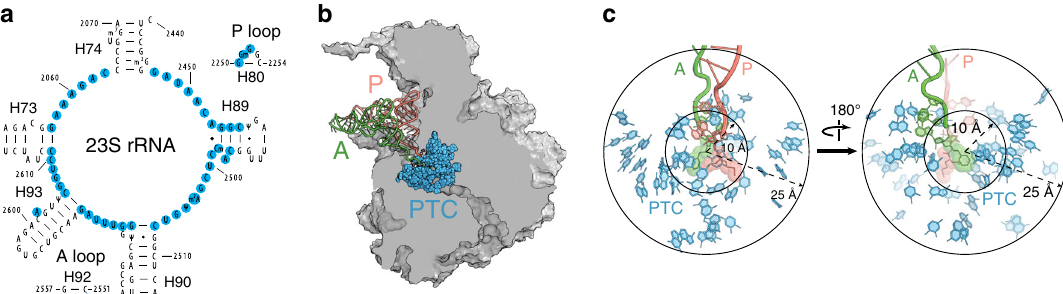
Fig. 7 The PTC mutant library. a The 23S rRNA residues whose mutations comprise the PTC library shown in the secondary structure diagram of the 23S rRNA domain V central loop. The relevant 23S rRNA hairpins are indicated. b The location of the mutated PTC nucleotides in the 50S ribosomal subunit. The subunit is shown in a cross-cut representation. The P- and A-site tRNAs are shown. c The distance of the mutated 23S rRNA residues from the PTC active site. All the 23S rRNA residues within the 10 Å radius (the inner shell) and a large fraction of those within the 25 Å radius (second shell) of the PTC active site were mutated. The aminoacylated acceptor ends of the P- and A-site tRNAs are shown in pink and